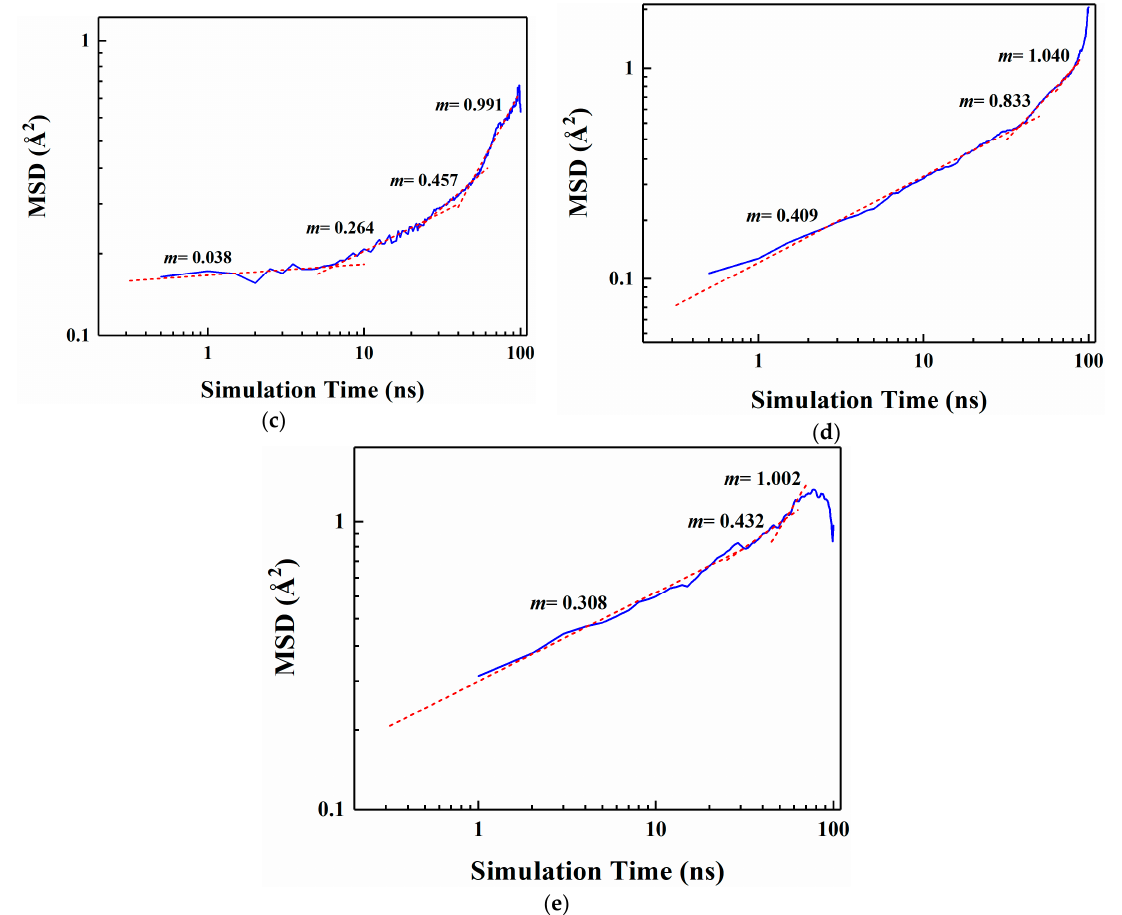
Figure 5. Segmental linear fitting diagrams of Log 10 curves for five organic molecules MSD. ( a ) D-limonene; ( b ) Myrcene; ( c ) Ethyl hexanoate; ( d ) 2-nonanone; ( e ) Linalool.